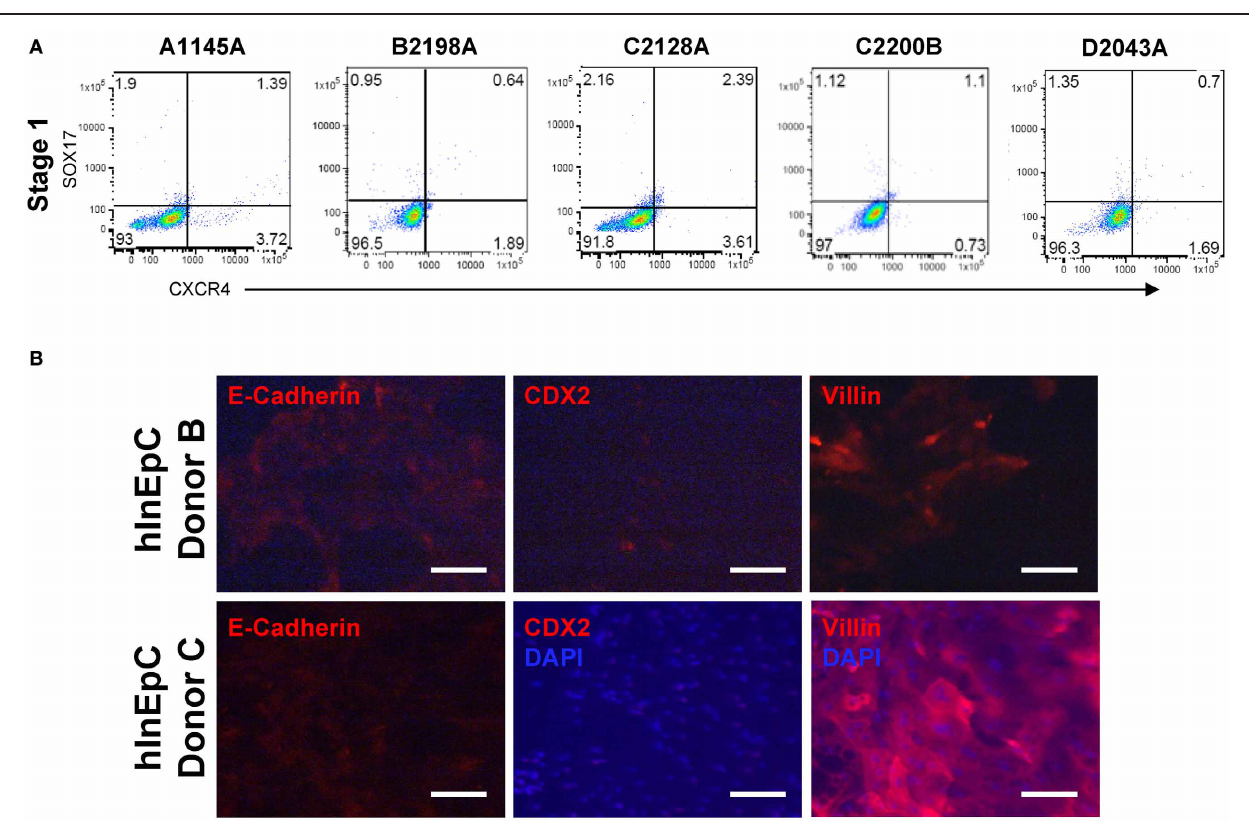
FIGURE A1 | Additional protein expression data. (A) Isotype controls used for flow cytometry plot gating in Figure 3B . (B) Expression of intestinal markers E-Cadherin, CDX2, and Villin is shown in primary hInEpC Donors B (top row) and C (bottom row).